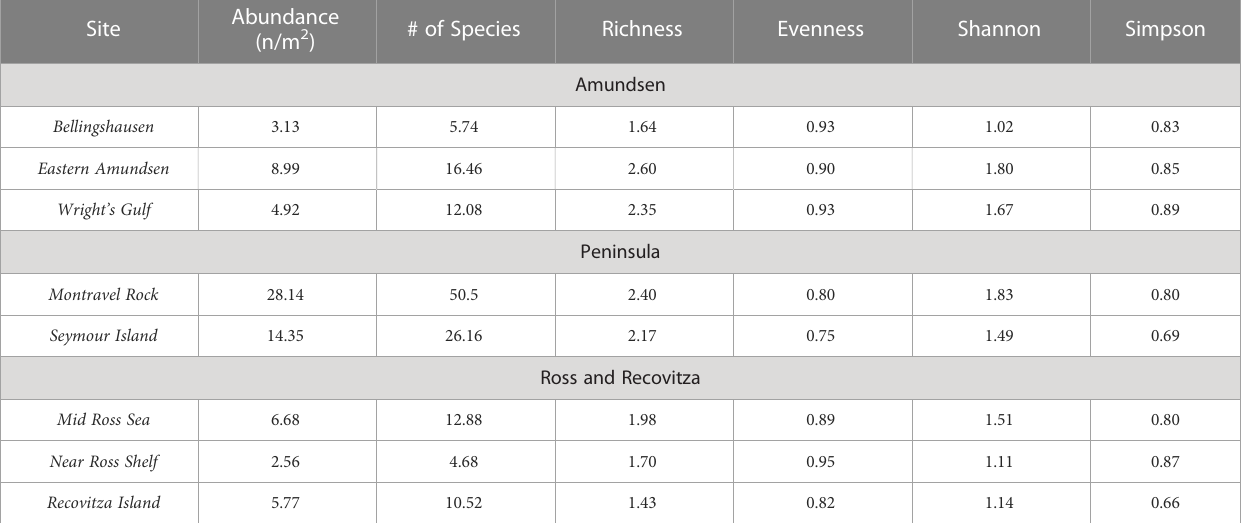
TABLE 1 Mean values for abundance, number of species, species richness, Pielou ’ s Evenness, Shannon-Wiener Diversity Index, and Simpson Index for all